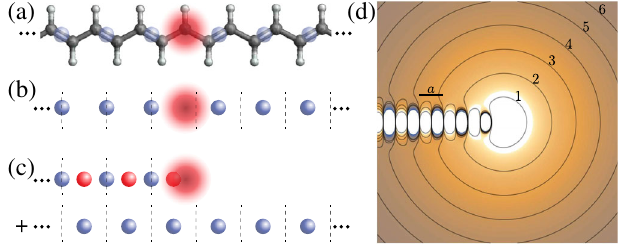
FIG. 7. (a) Polyacetylene ð CH Þ n features an alternation be- tween single and double covalent bonds along the carbon backbone. The domain wall traps an additional effective orbital, which we assume to be unoccupied here. Such an unoccupied domain wall has an effective positive charge of e (red blob), the elementary charge. (b) In a purely electronic description, the main difference between the two sides of the domain wall is the location of the double bond. This can be described as localizing a pair of electrons (blue spheres) to either the boundary or the center of the unit cell (indicated by dashed line). (c) By introducing holes (red spheres; each of them representing a pair of holes as it is the “ inverse ” of a blue sphere), we can rewrite the charge distribution in (b) into the sum of a semi-infinite chain of alternating point charges and an infinite periodic chain. The charge bound to the domain wall emerges at the end point of the semi-infinite chain. (d) Electrostatic potential of a semi-infinite chain of alternating point charges of charge (cid:1) q . In the polyacetylene example q ¼ 2 e . The equipotential lines at ð q= 2 Þ = ð 4 πϵ na Þ for n ¼ 1 ; 2 ; … ; 6 are shown and labeled by 0 n , which confirms the emergence of an edge charge q= 2